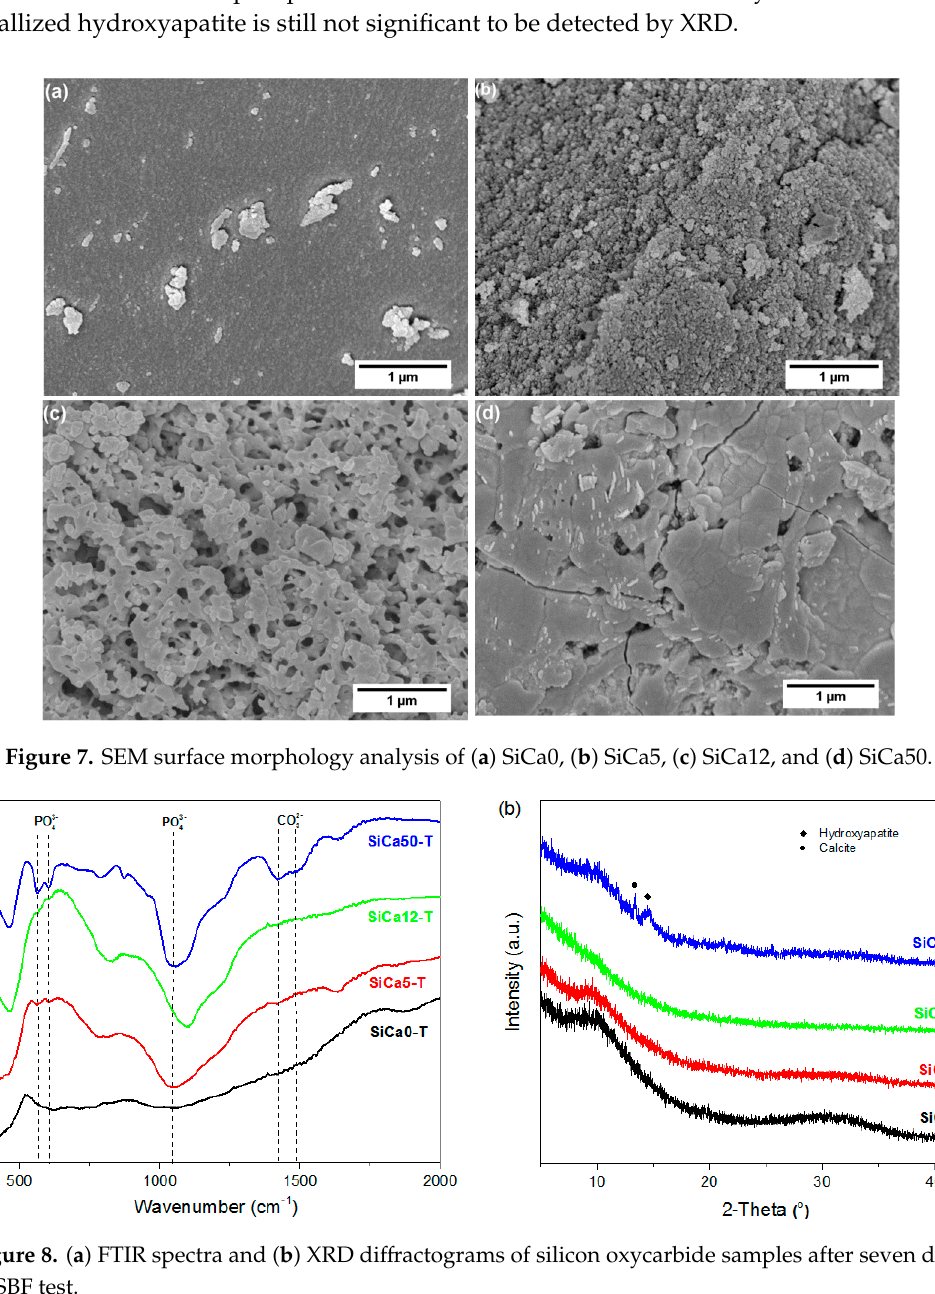
Figure 6. Schematic illustration of the porosity evolution from gels to xerogels, and then to silicon oxycarbide materials and the porosity dependency on the designed Ca/Si molar ratio.